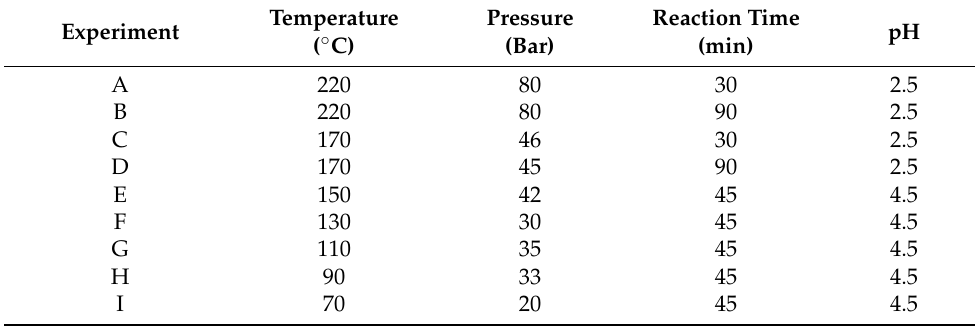
Table 1. Experimental conditions for the Sol-Gel assisted by